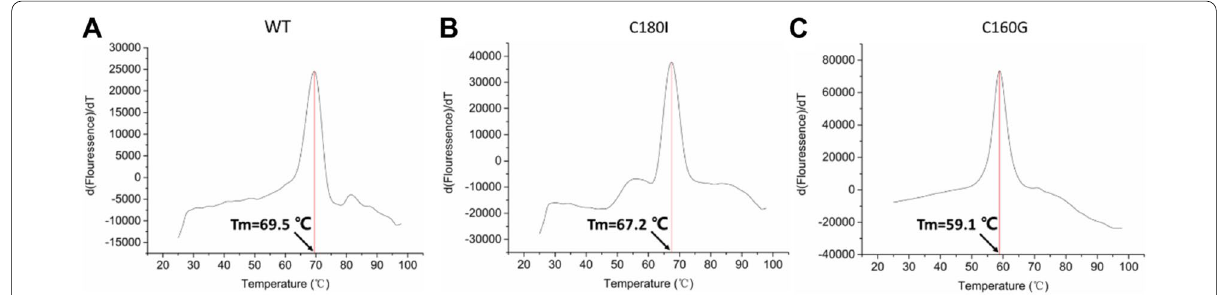
Fig. 6 Tm values of WT, C160G, and C180I. The T m values are 69.5 °C for WT ( A ), 67.2 °C for C180I ( B ), and 59.1 °C for C160G ( C ),